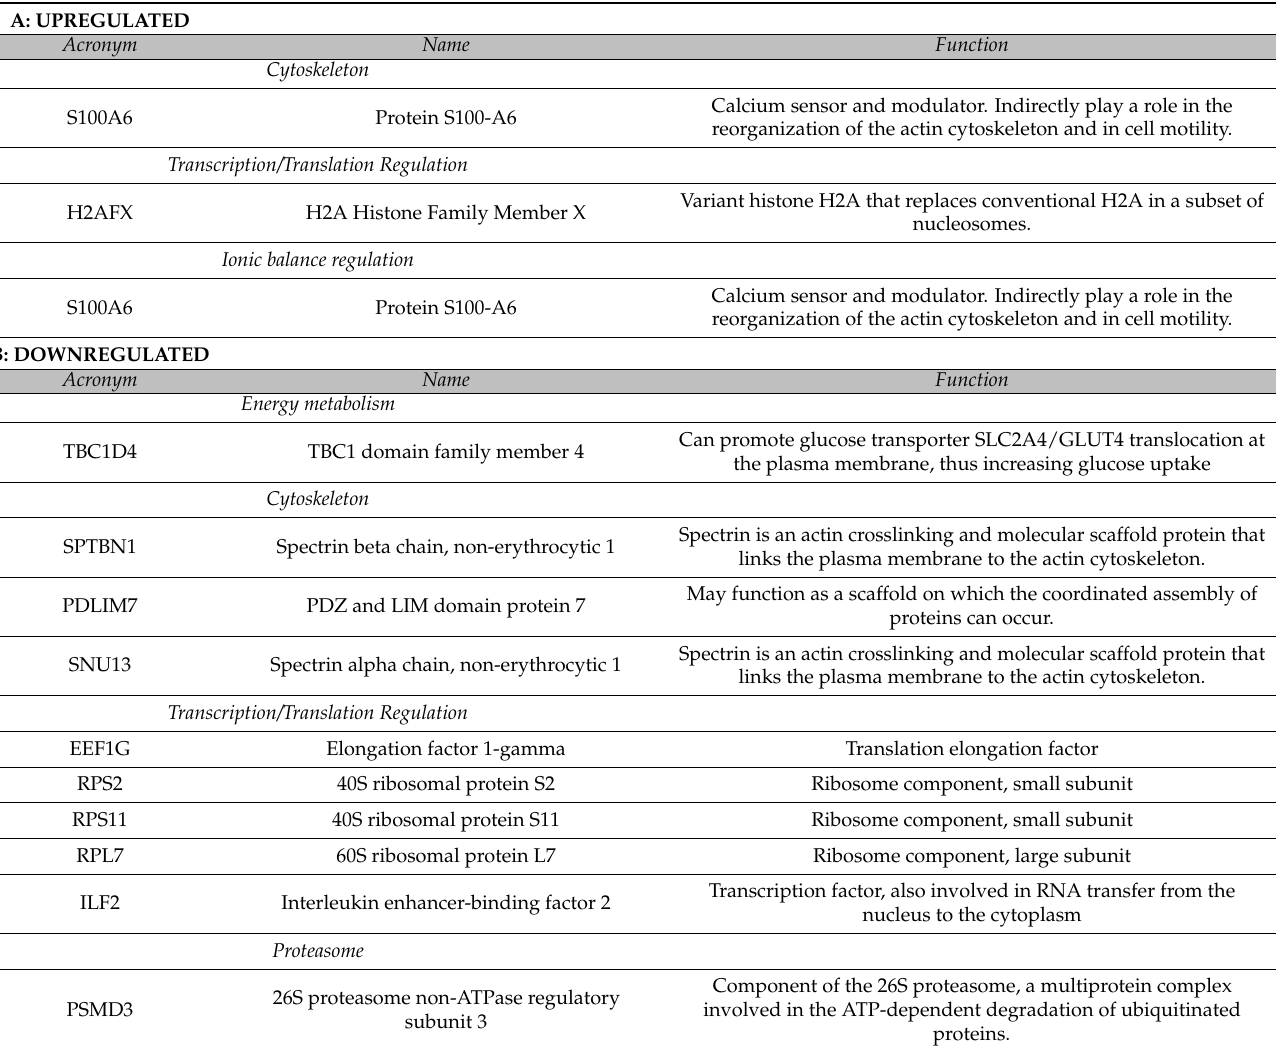
Table 6. Proteins which expression was altered between H19 and H24.